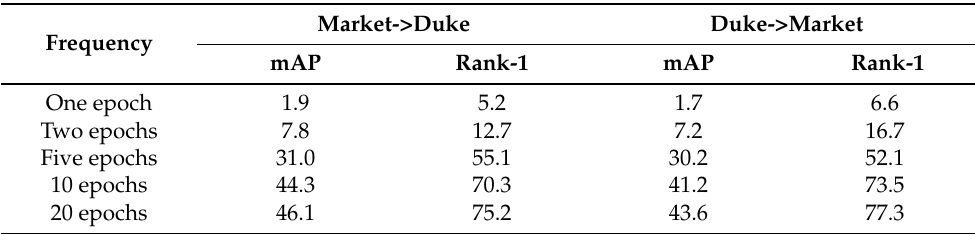
Table 2. Iteration frequency. We compare different iteration frequencies, such as 10 epochs per iteration. This represents that the pre-trained source model will be fine-tuned by optimized clustering results per 10 epochs.